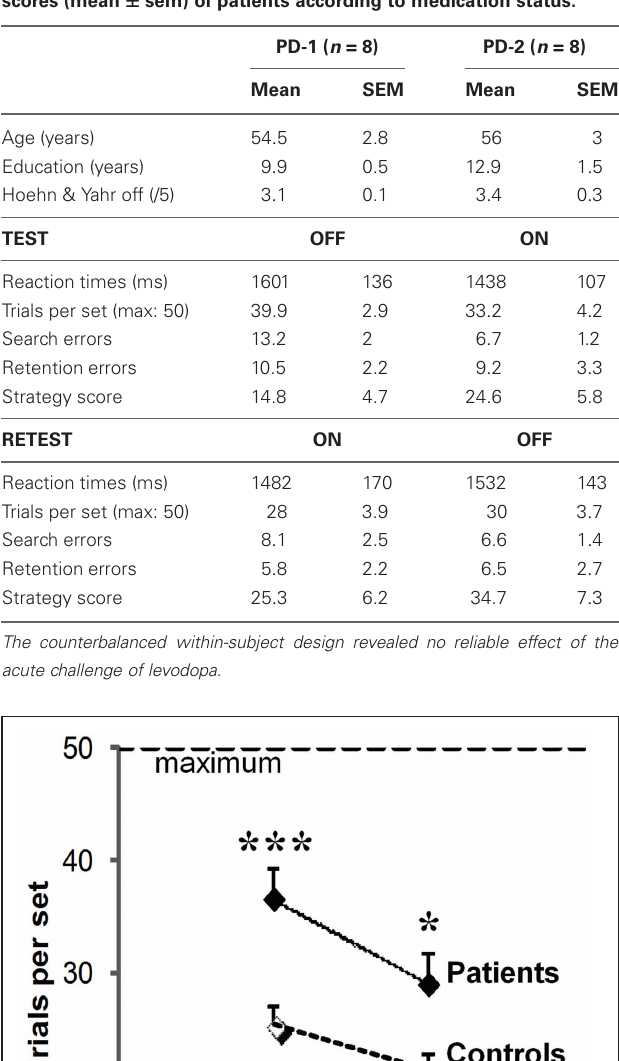
Table 3 | Age, education level, disease stage, and conditional learning scores (mean ± sem) of patients according to medication status.